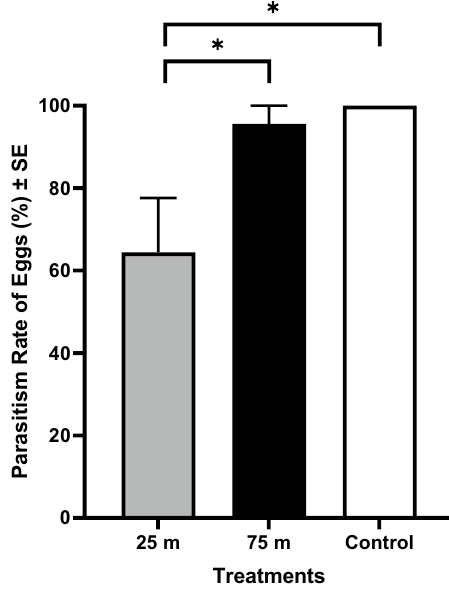
Figure 2. Effect of malathion on parasitism of monarch ( D. plexippus ) eggs. Rate of parasitism by T. platneri on monarch eggs affixed to host plant leaves (N = 5 per plant and N = 135 total) treated with malathion via truck- mounted sprayer at the maximum label rate. Asterisks indicate significant differences between groups ( p < 0.05), using GLM with the Poisson distribution.